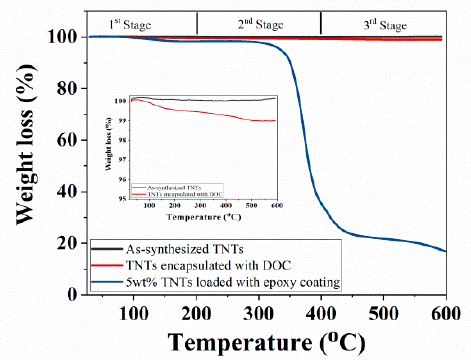
Figure 5. TGA analysis of as-synthesized TNTs, TNTs loaded with DOC, and nanocomposite.